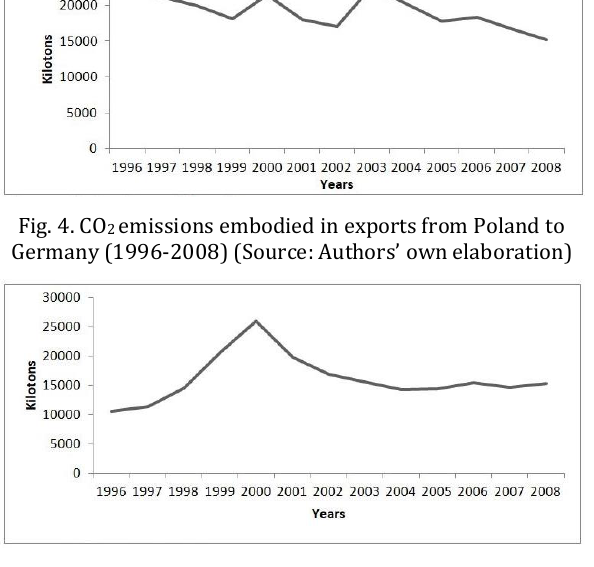
Fig. 5. CO 2 emissions embodied in the imports from Russia to Poland (1996-2008) (Source: Authors’ own elaboration)